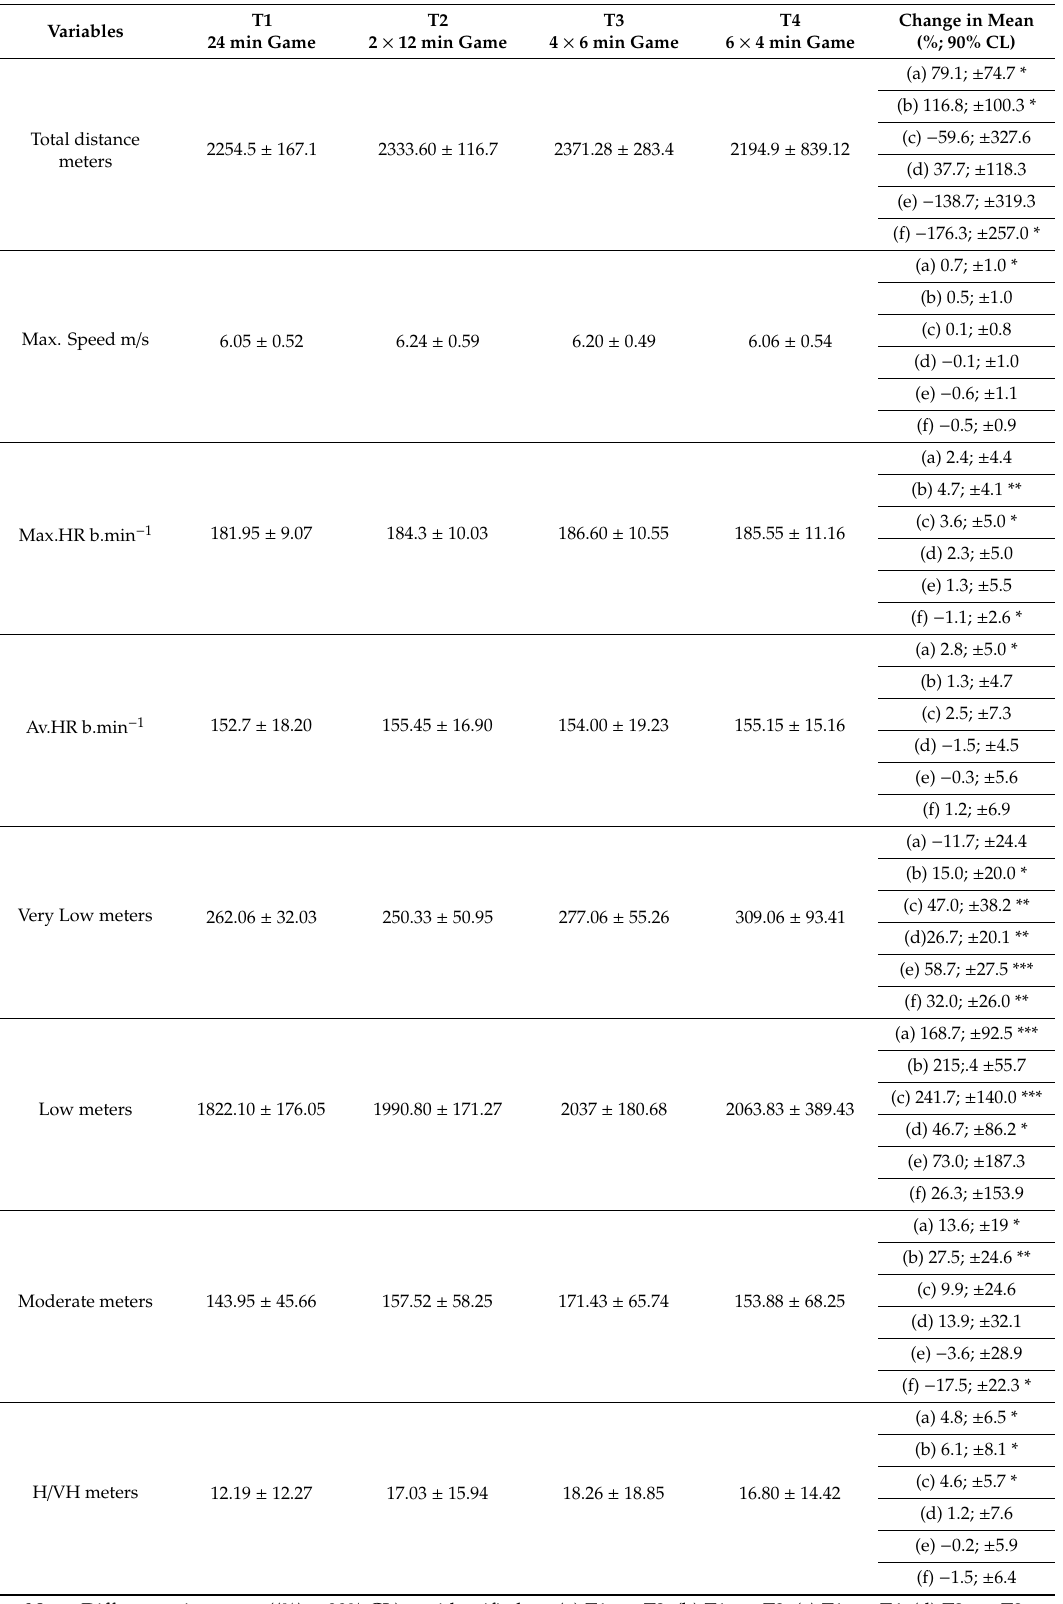
Table 1. Descriptive statistics on the di ff erent condition